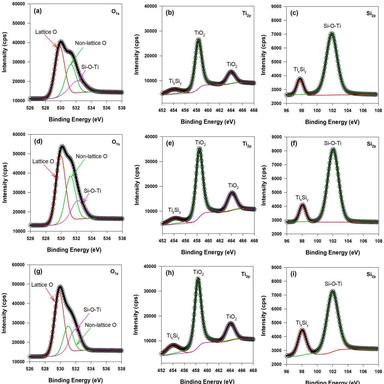
High resolution XPS spectra of O 1s, Ti 2p and Si 2p in the membranes prepared by different powders with sintered pressure of 30 kPa at 1000 ℃, (a), (b) and (c): coarse powder; (d), (e) and (f): middle powder; (g), (h) and (i): fine powder.